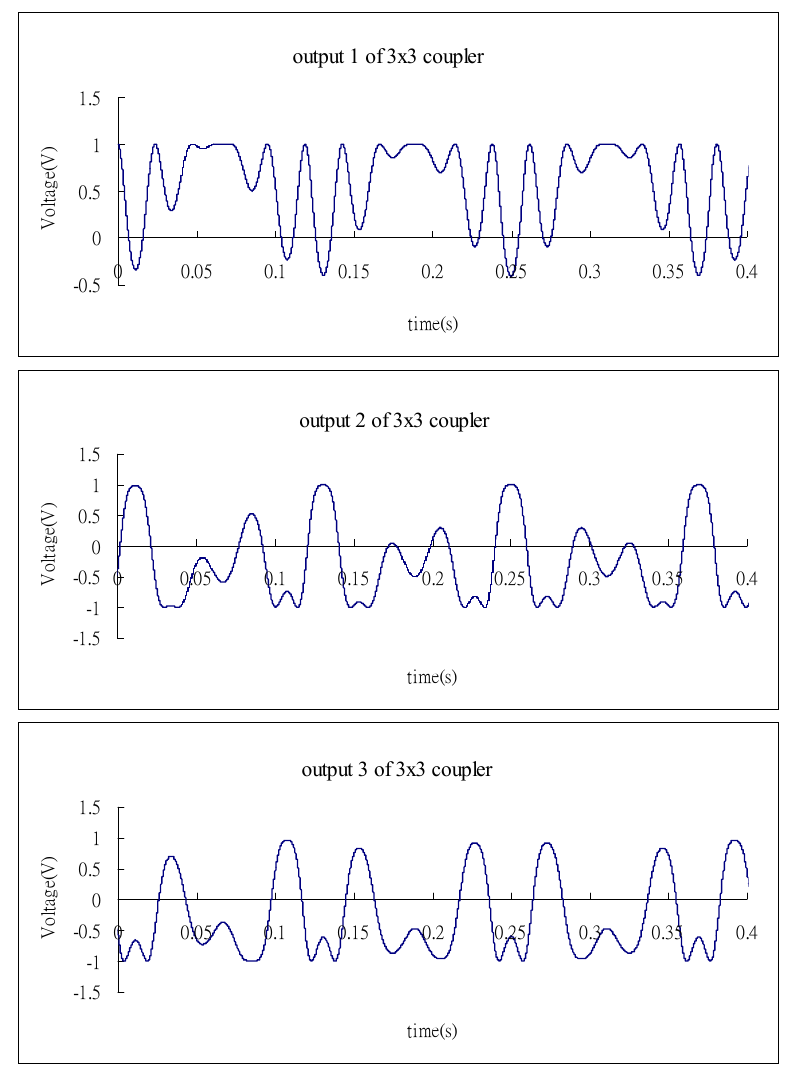
Figure 4. Three outputs of the 3 × 3